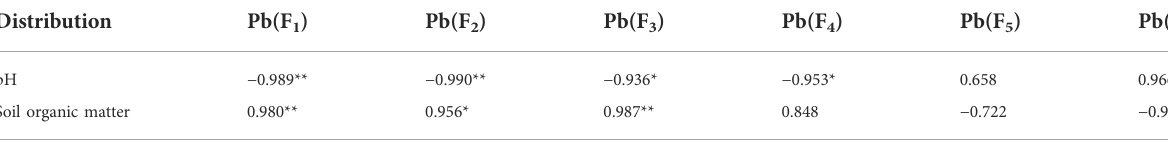
TABLE 3 Pearson ’ s correlation among soil pH, soil organic matter, and distribution (F 1 ~F 6 ) of Pb. Distribution